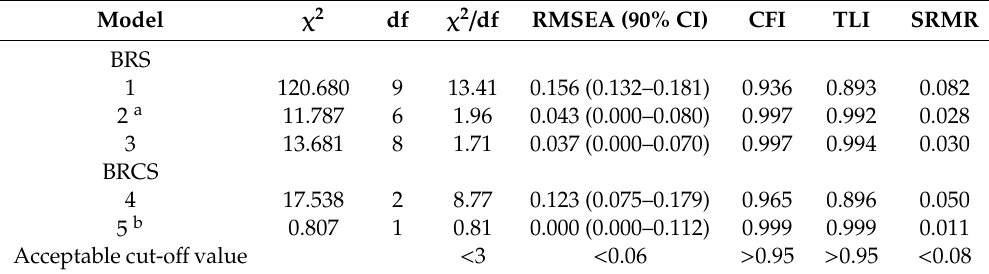
Figure 1. The final standardised model of the two-factor BRS. Note. PPF = positive polarity factor; NPF = negative polarity factor. Table 3. Confirmatory Factor Analysis of the BRS and the